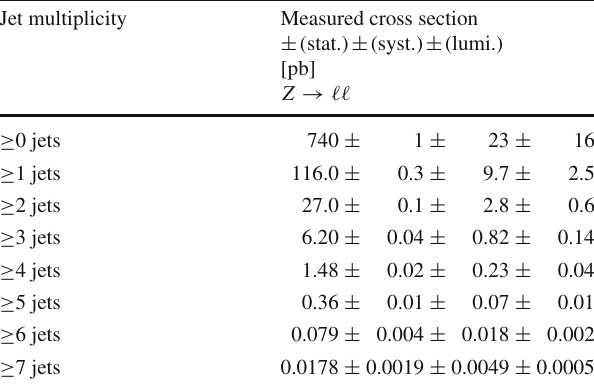
Table 5 Measured combined fiducial cross sections for successive inclusive jet multiplicities. The statistical, systematic, and luminosity uncertainties are given